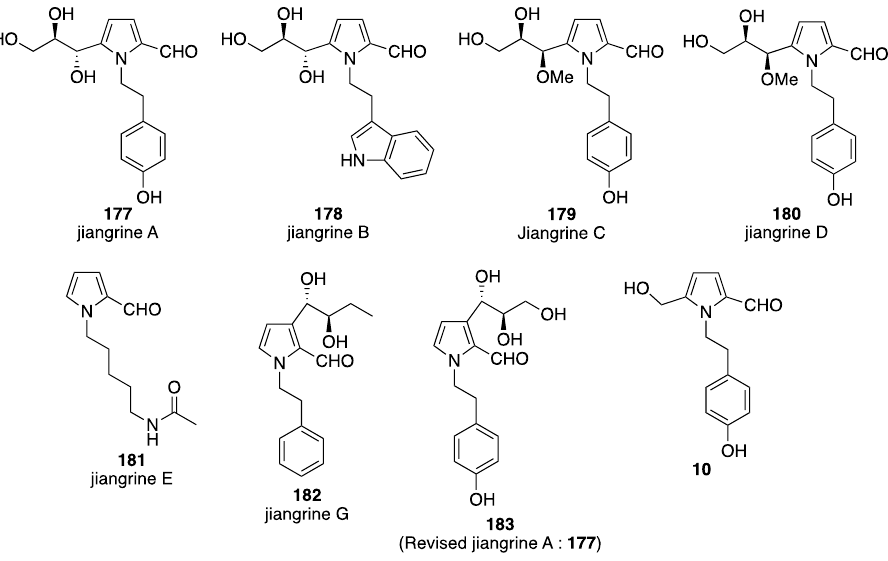
Figure 6. Structures of Py-2-Cs from microorganisms.